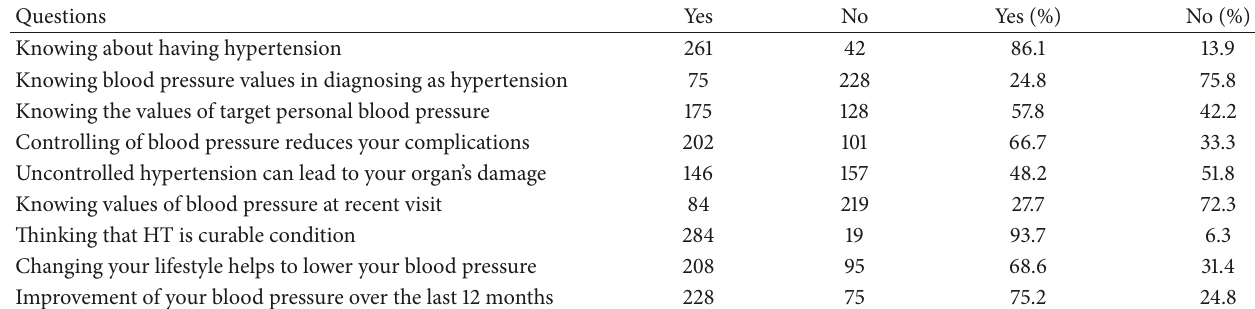
Table 3: Patient’s awareness of